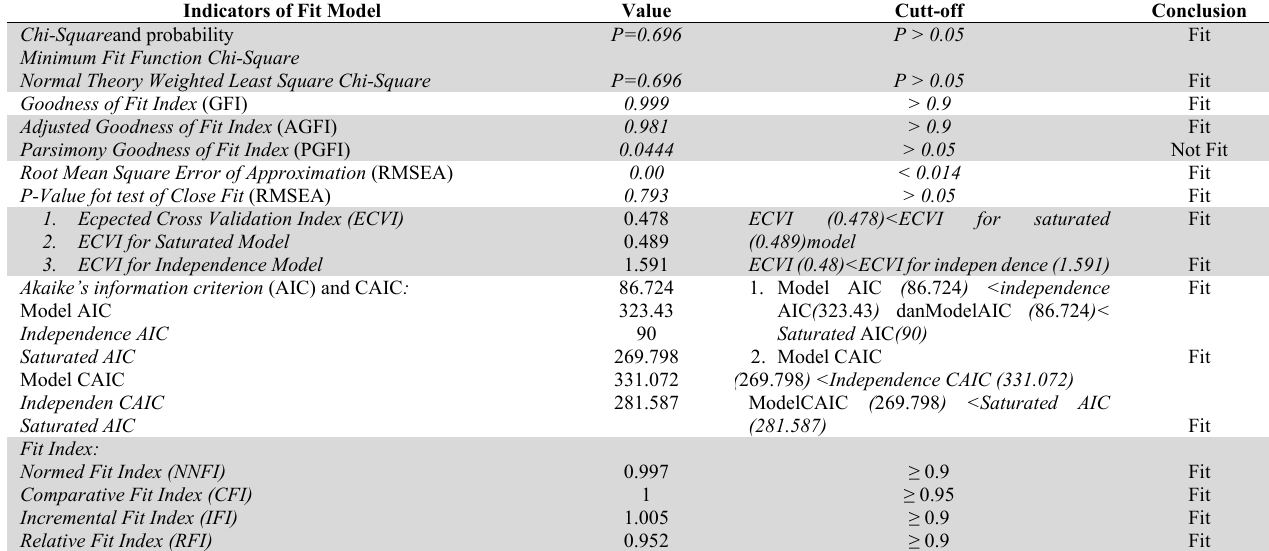
The Result of Goodness of Fit Model Test Indicators of Fit Model Value Cutt-off Conclusion Chi-Square and